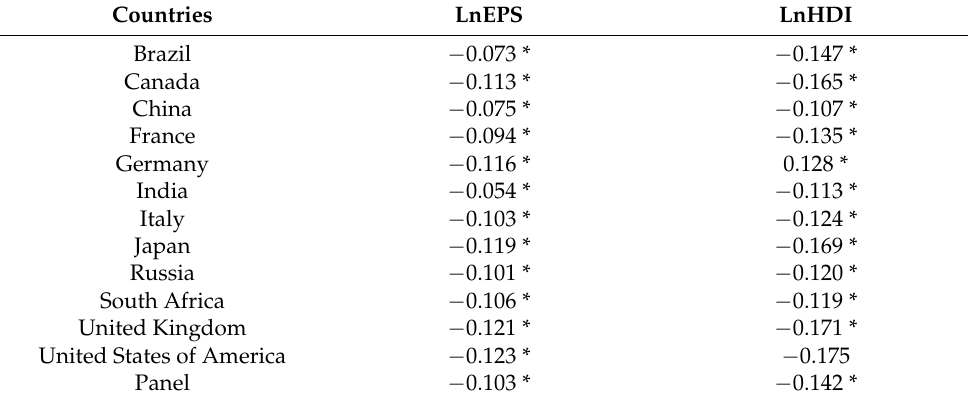
Table 7. Cointegration